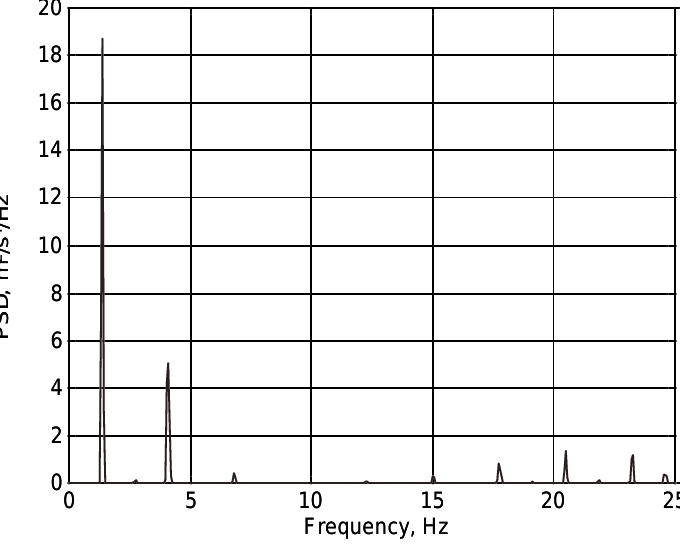
Fig. 9. Sprung mass acceleration (system response) power spectral density due to a 1.4 Hz pure tone excitation for a skyhook damper. series, in which the magnitude for higher frequencies decay toward